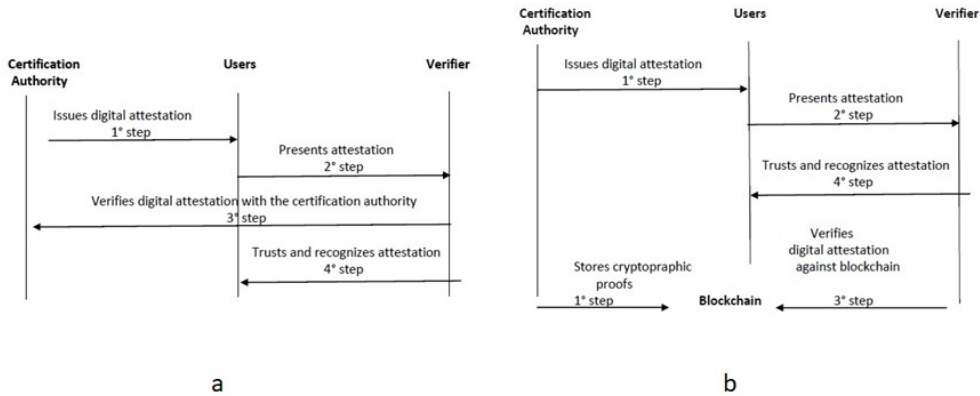
Figure 2. ( a ) Traditional Process of verification and ( b ) Process of verification in SSI